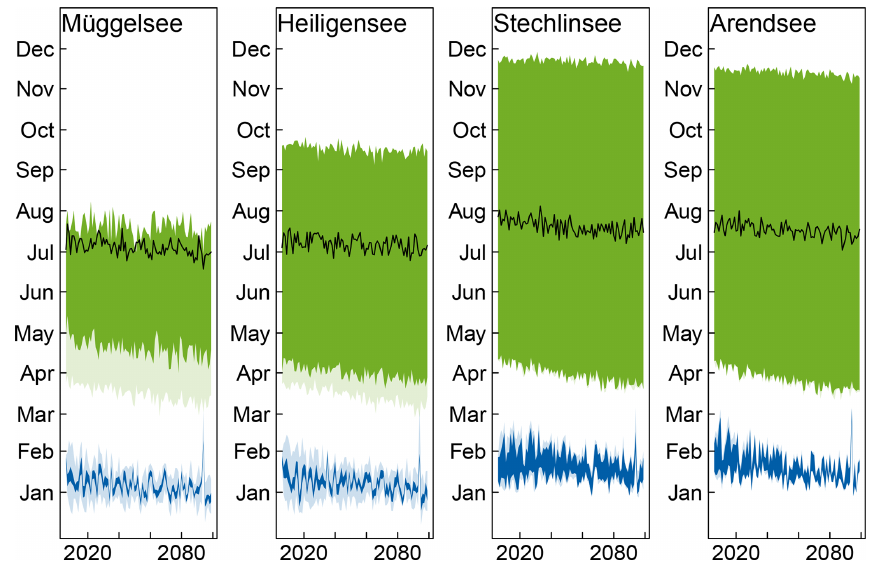
Figure 9. Projected trends in stratification in the four study lakes. Green shading shows summer stratification, blue shows winter stratification. Lighter shading indicates intermittent stratification. The black line shows the timing of maximum surface temperature. The model was forced with the baseline (historical)